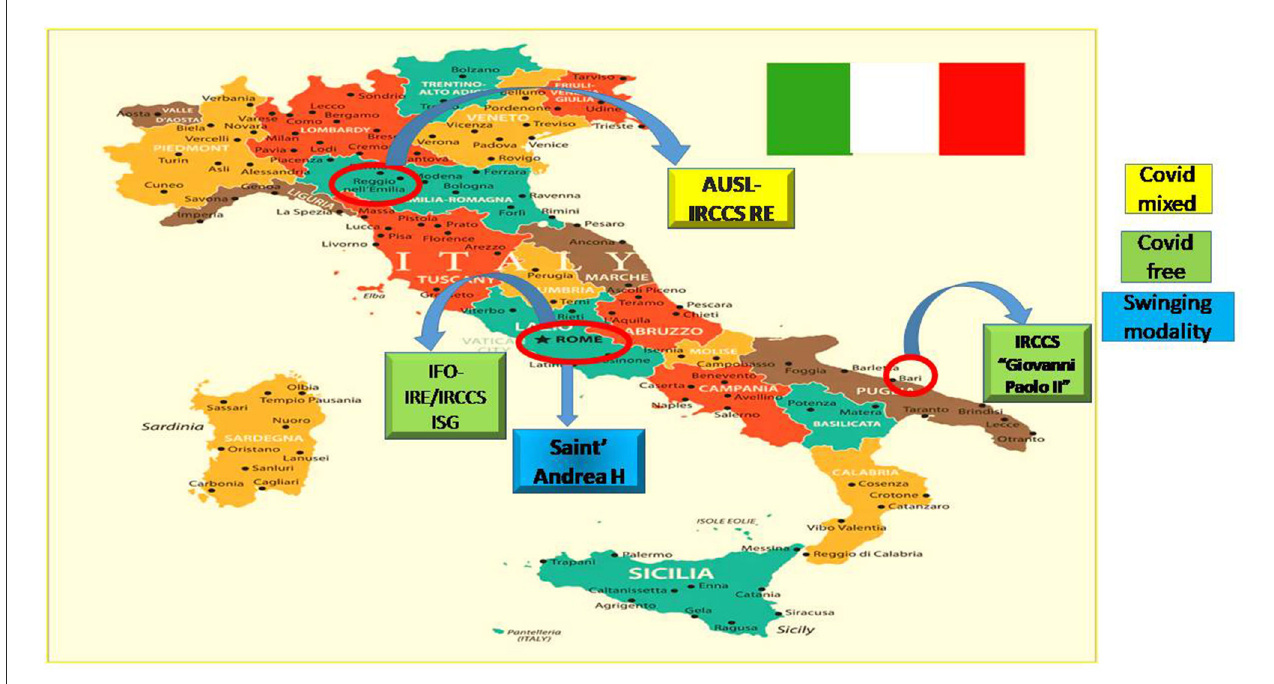
FIGURE1 Map of the clinical centers involved in the COMETA project. AUSL IRCCS (Reggio Emilia), IRCCS IFO/IRE (Rome), and IRCCS “Giovanni Paolo II (Bari) are CCC (Comprehensive Cancer Care) centers. Saint’ Andrea Hospital is a University Hospital Center based in Rome.